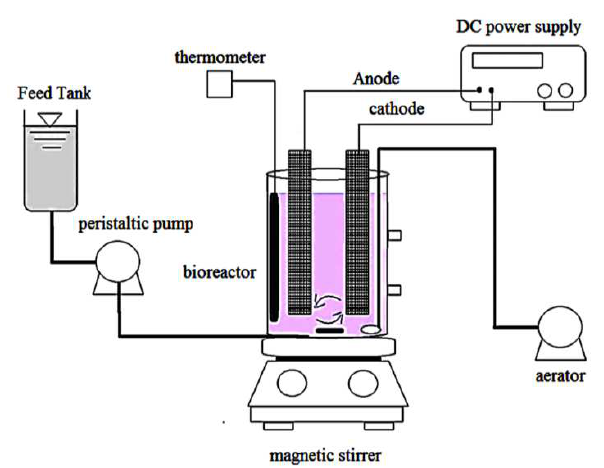
Figure 1. Schematic plan of bioelectrochemical nitrification system (BNS)